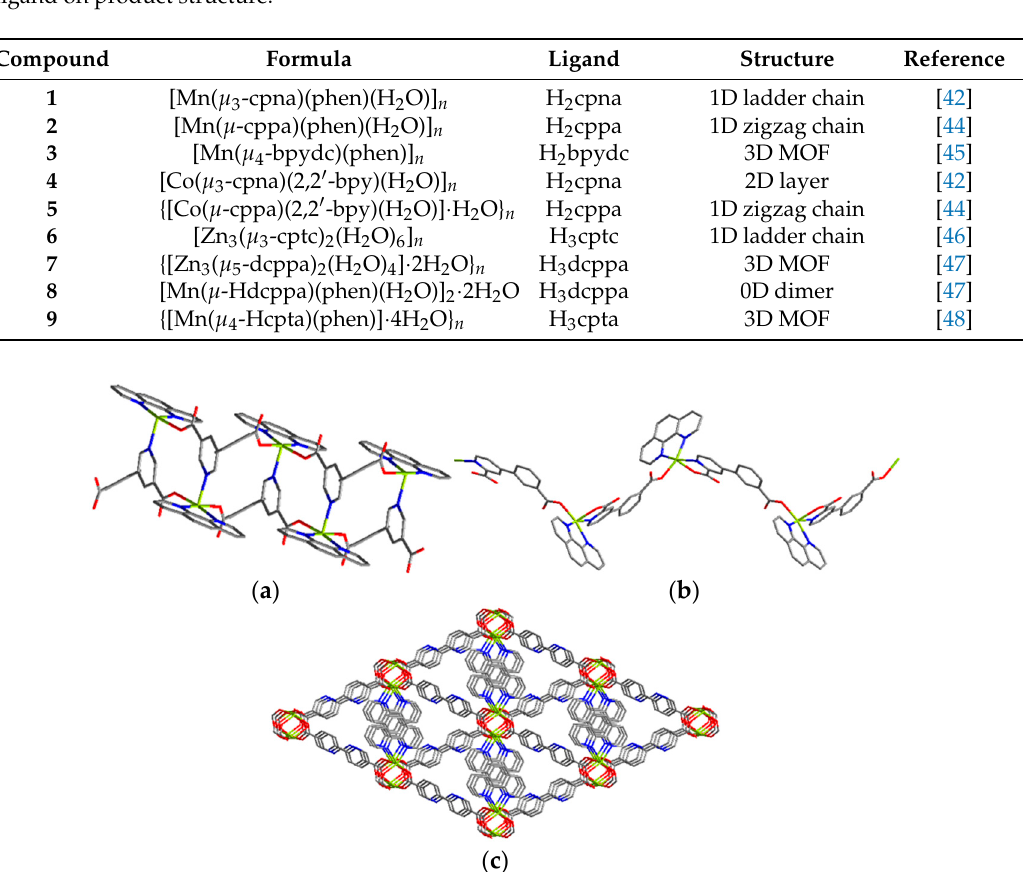
Figure 3. ( a ) 1D ladder chain in 1 . ( b ) 1D zigzag chain in 2 . ( c ) 3D metal-organic framework in 3 . Adapted from